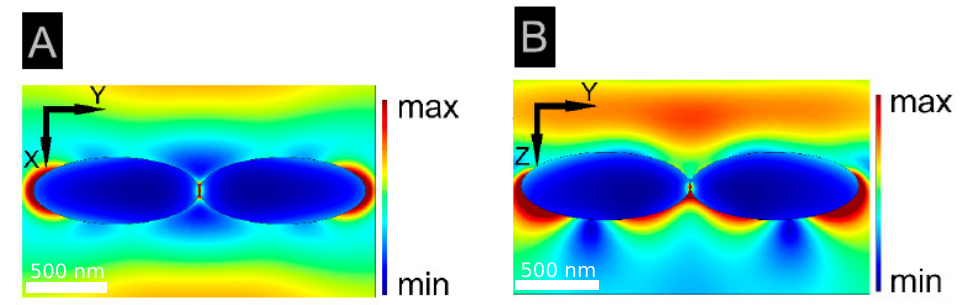
Figure 10. Electric field intensity maps at Fano resonance—1440 nm in the XY-plane ( A ) and YZ-plane ( B